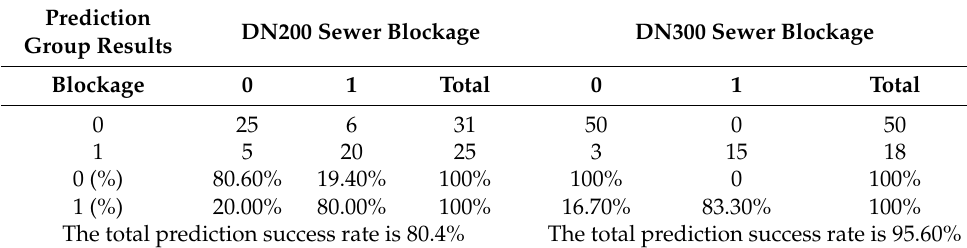
Table 4. Sewer blockage identification model prediction group